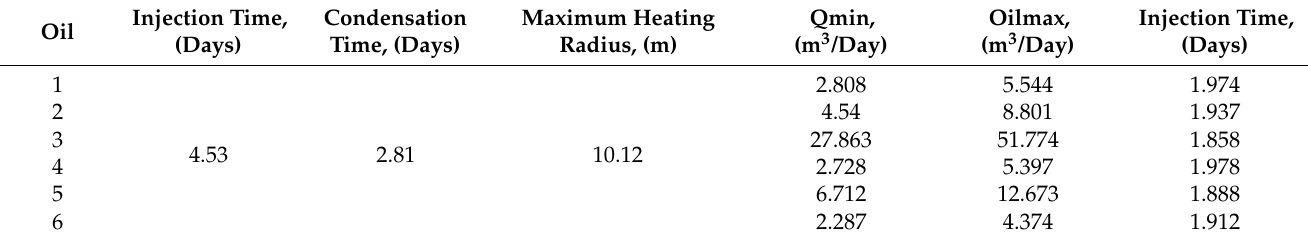
Table 3. Calculation results for optimal steam injection time, condensation time, maximum heating radius and pre-treatment and post-treatment well